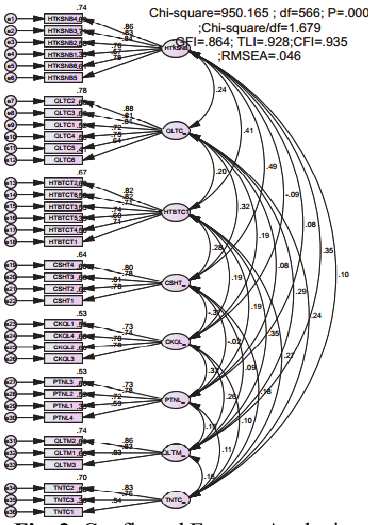
Fig. 3. Confirmed Factors Analysis Fig. 4. SEM model test